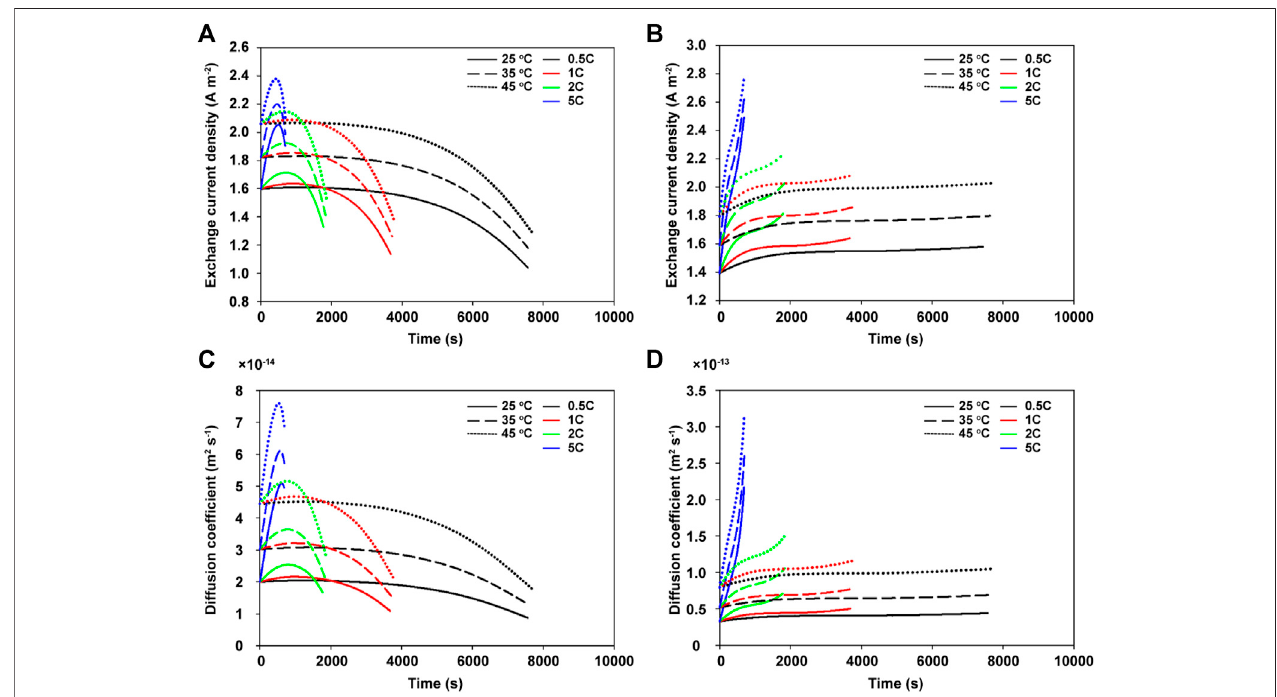
FIGURE 4 | Simulated voltage pro fi les of the cell model as a function of the C-rate (0.5, 1, 2, and 5C) at exterior temperatures of (A) 25 ° C, (B) 35 ° C, and (C) 45 ° C. Experimentally measured data also overlapped in each pro fi le.